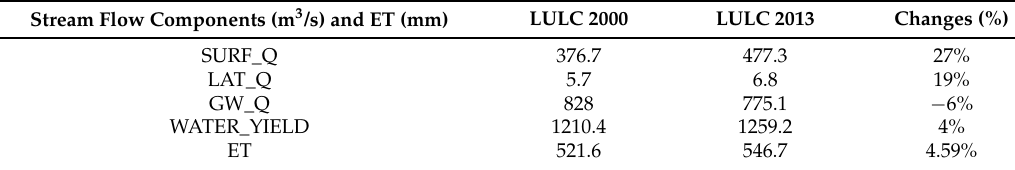
Table 9. Stream Flow Components Change Due to